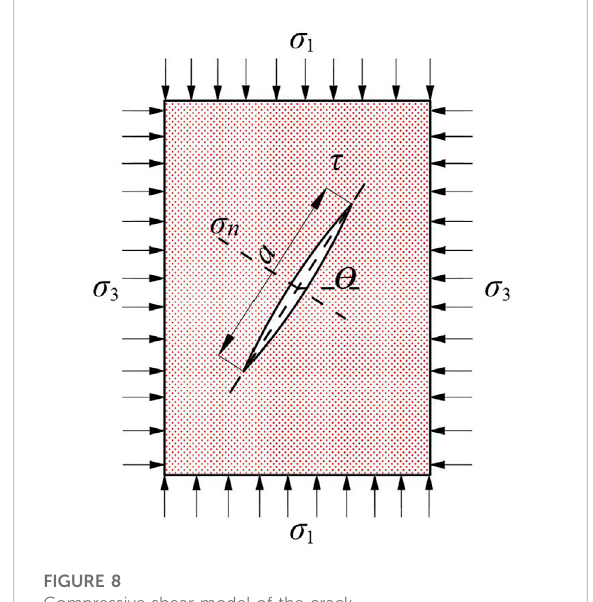
FIGURE 8 Compressive shear model of the